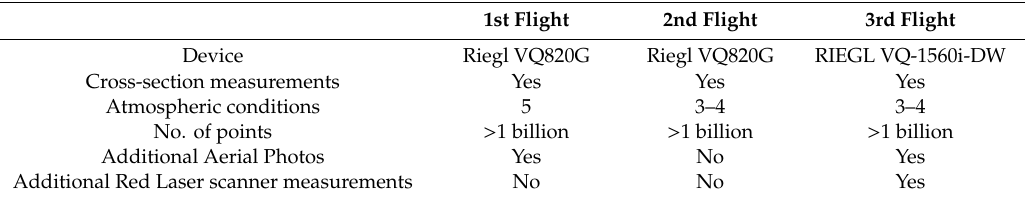
Table 1. Measurement characteristics taken for each